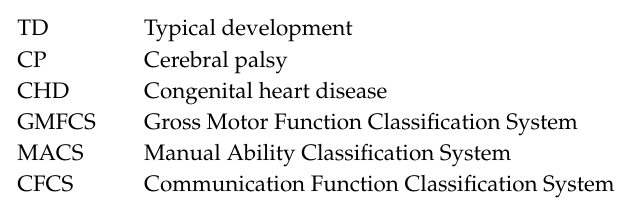
Table S1: Main and interaction e ff ects of longitudinal statistical analyses for children with PD and TD